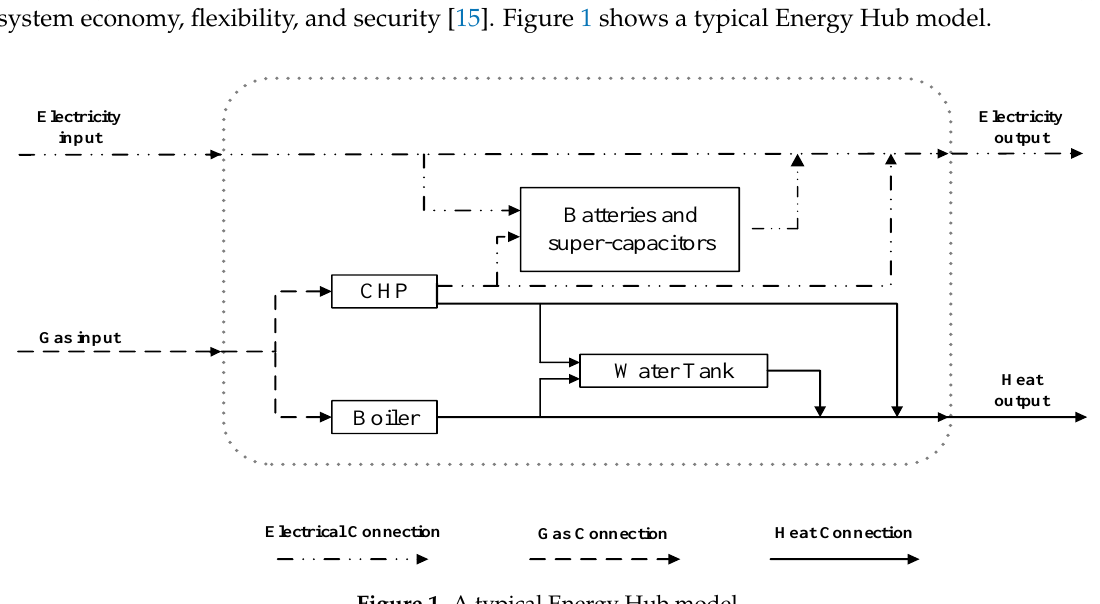
Figure 1. A typical Energy Hub model.